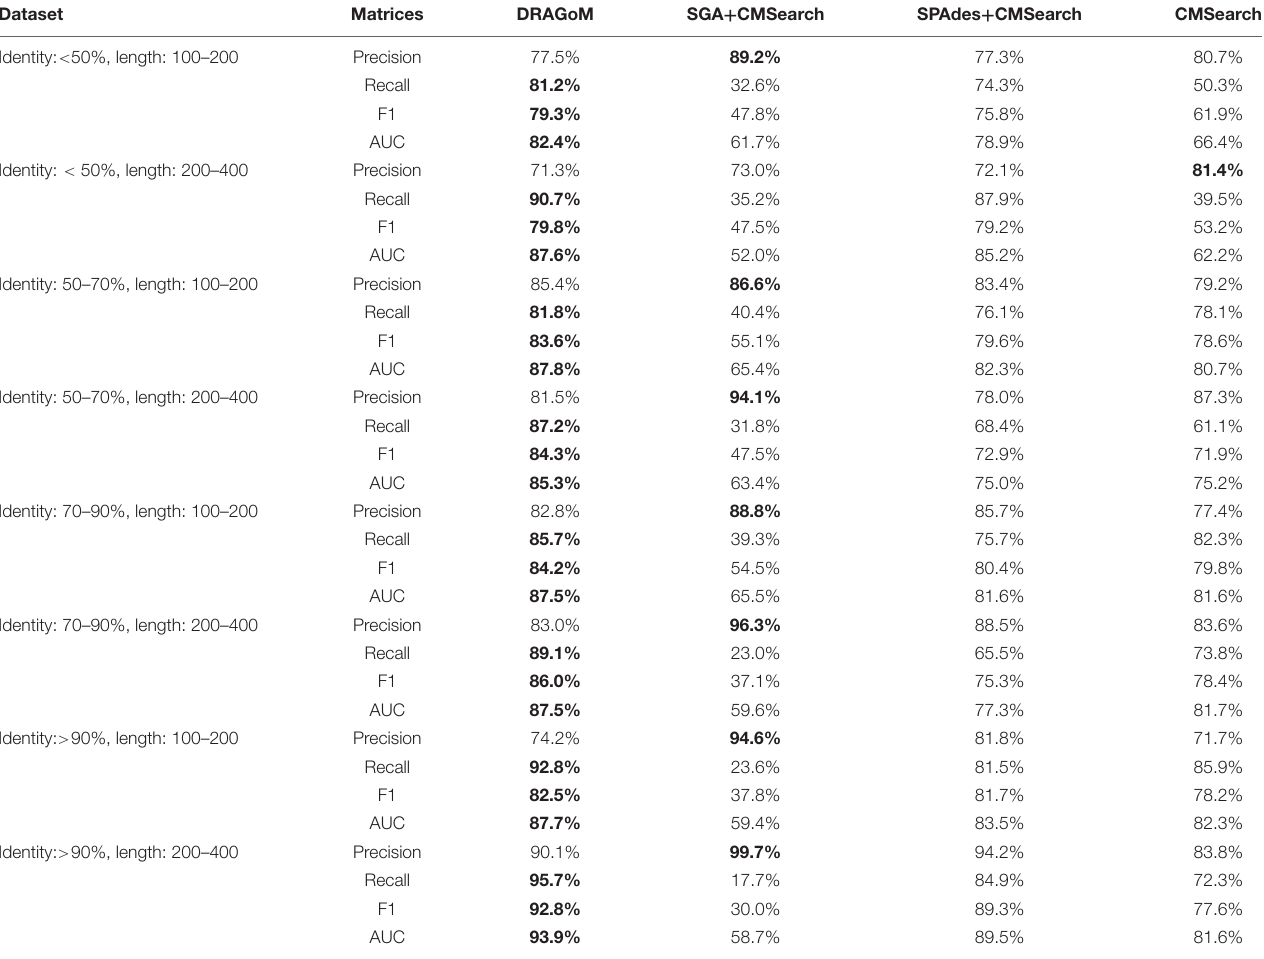
TABLE 4 | Performance summary of the tested methods on DS5 (for non-16S rRNA queries). Dataset Matrices DRAGoM SGA + CMSearch SPAdes +